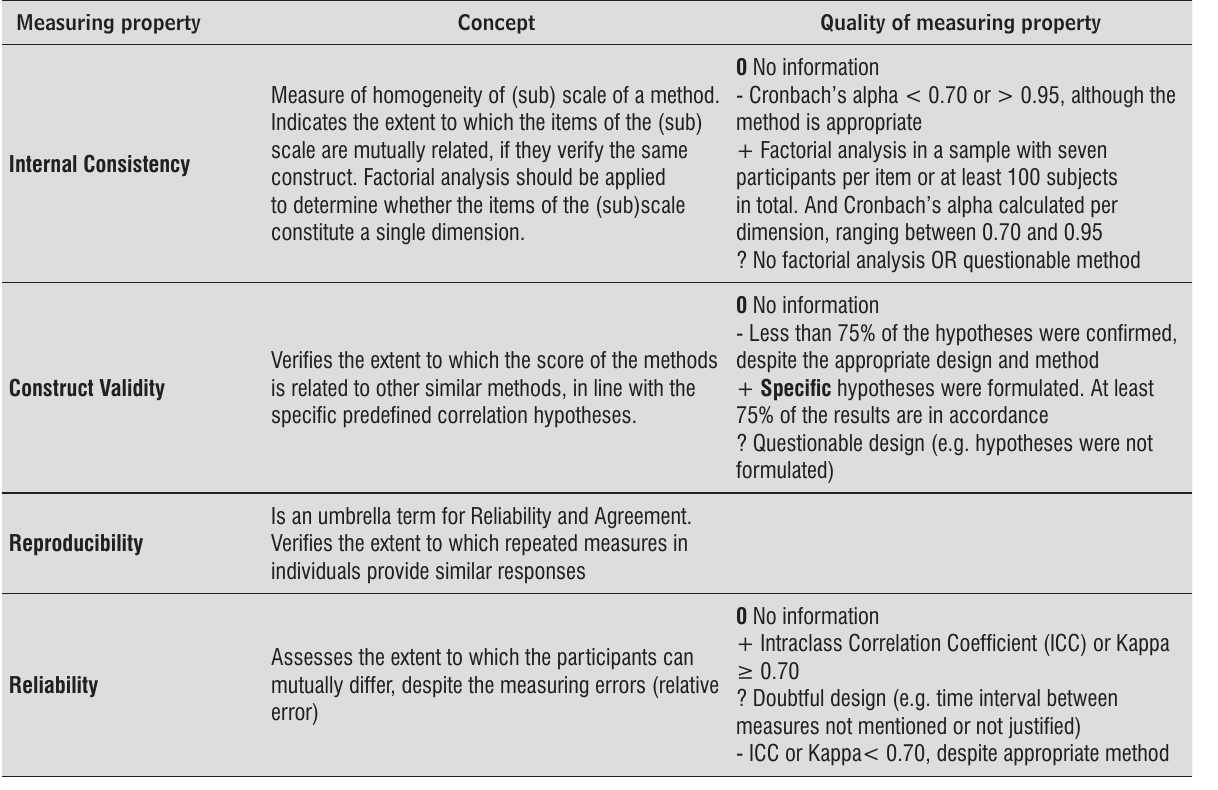
Table 2 - Quality Criteria for Measuring Properties of Questionnaires in Health (11, 12,